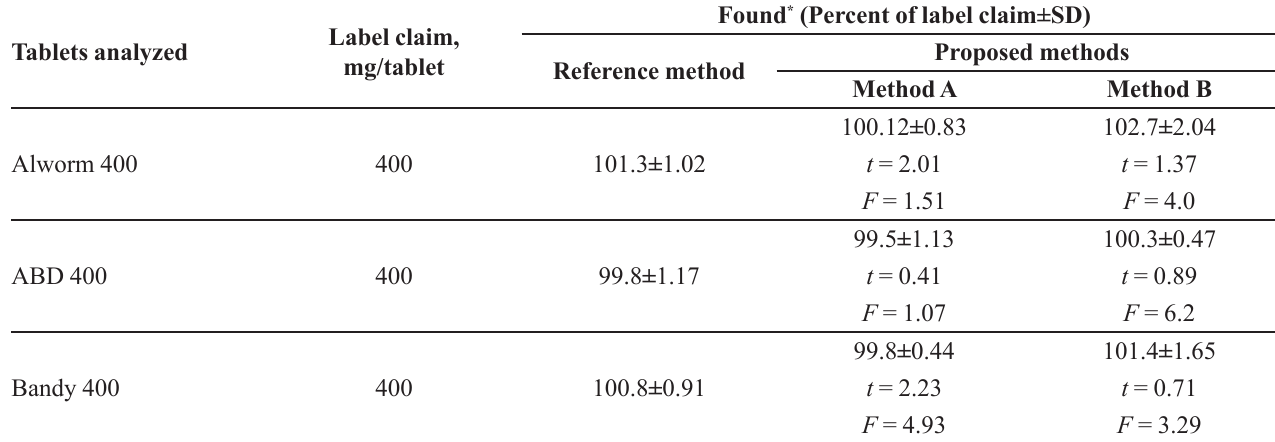
TABLE V - Results of analysis of tablets by the proposed methods